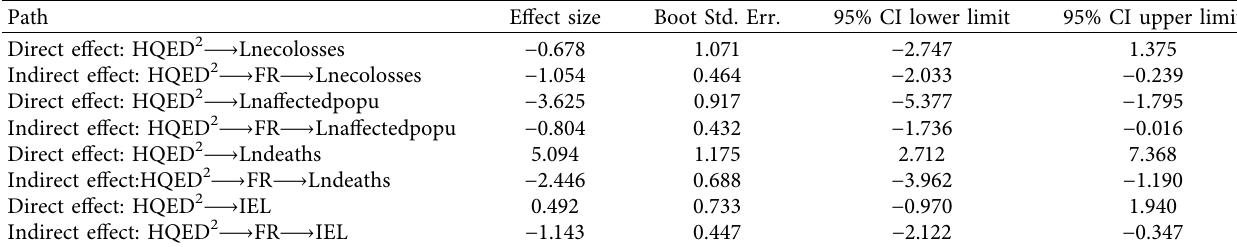
Table 8: Bootstrap test results of mediating